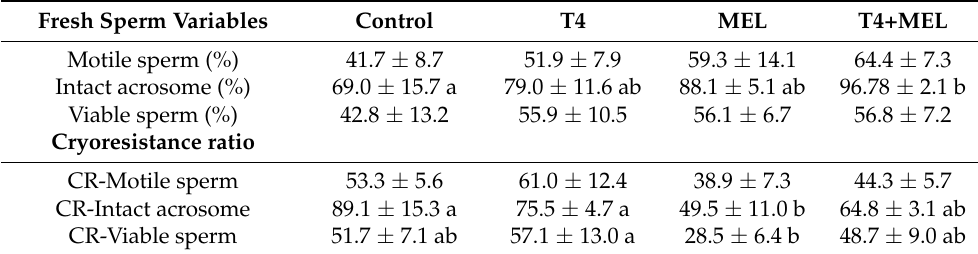
Figure 1. Plasma thyroxine ( A ) and testosterone ( B ) concentrations in ibexes: Controls (red); treated with thyroxine (T4, green); treated with melatonin implants (MEL, blue); and treated with melatonin implants plus thyroxine (MEL+T4, gray). Box plots show the median (horizontal line) and spread from the 1st to the 3rd quartiles; the whiskers extend from the smallest to the largest value. Outliers are shown as circles. Different letters (a,b) between boxplots indicate significant differences ( p < 0.001 for ( A ) and p < 0.01 for ( B )). Table 1. Ibex fresh sperm variables and cryoresistance ratios (CR) for the control, T4 (treated with thyroxine), MEL (treated with melatonin implant), and T4+MEL (treated with thyroxine plus melatonin implant) groups. Different letters indicate significant differences ( p < 0.05).